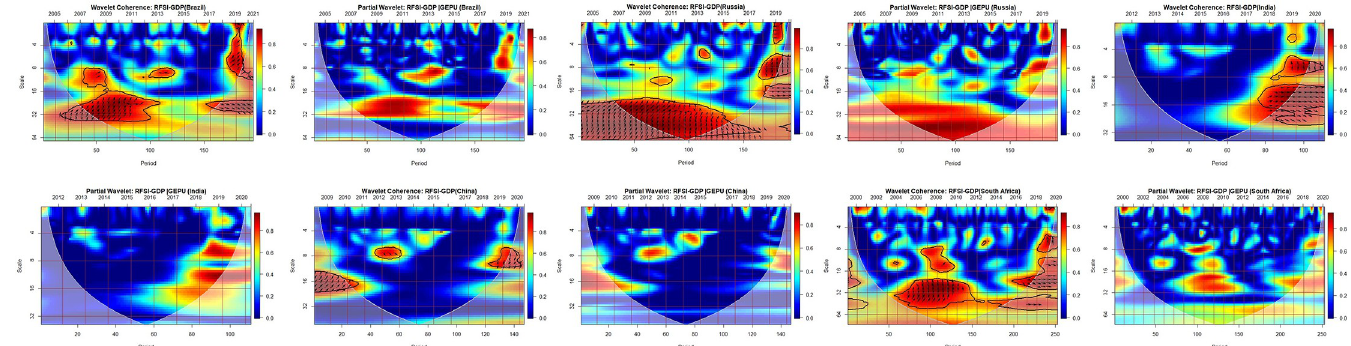
Fig 2. Nexus between RFSI-GDP while considering external uncertainty